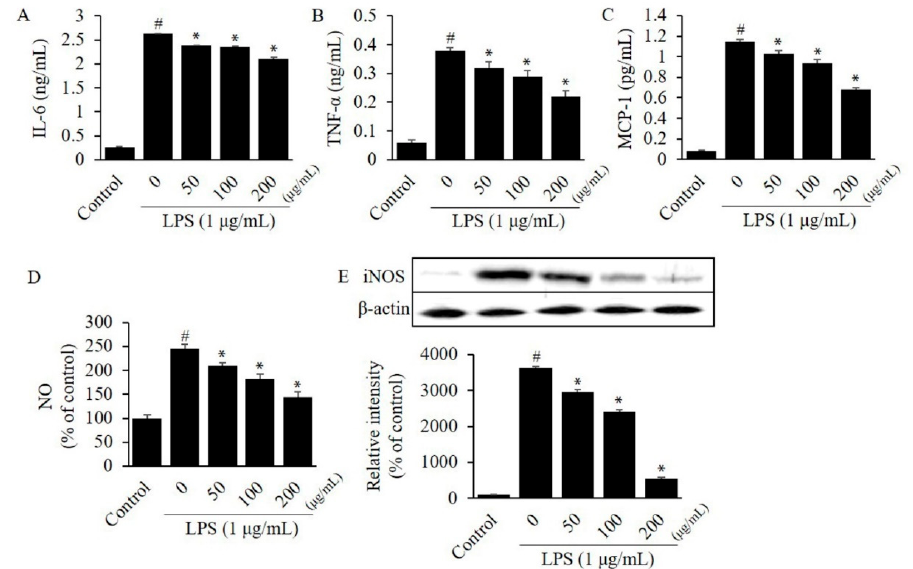
Figure 3. Effect of CTFV on the inflammatory response in RAW264.7 cells. The levels of IL-6 ( A ), TNF-